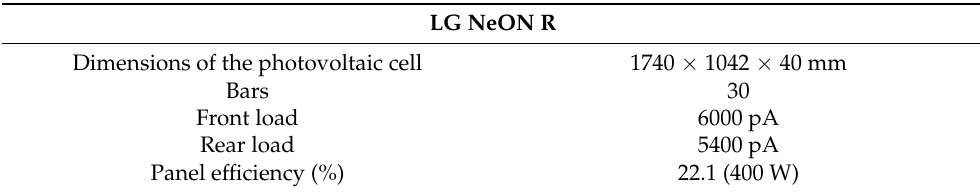
Table 3. LG NeON R [53].